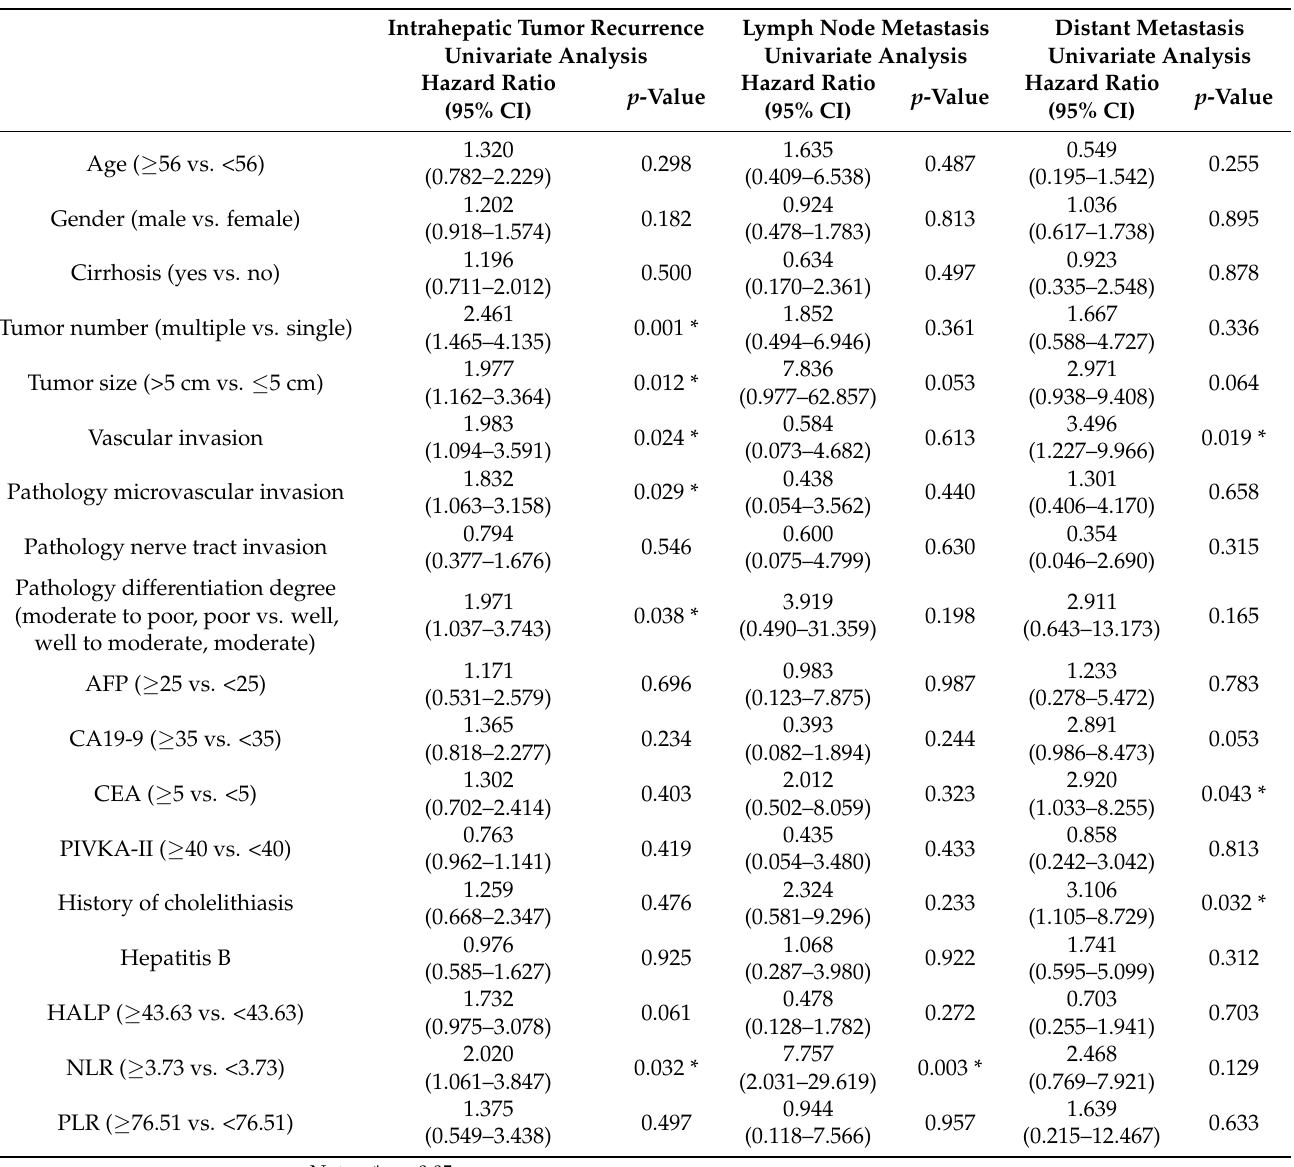
Table 4. Univariate analysis for intrahepatic tumor recurrence, lymph node metastasis, and distant metastasis in patients with